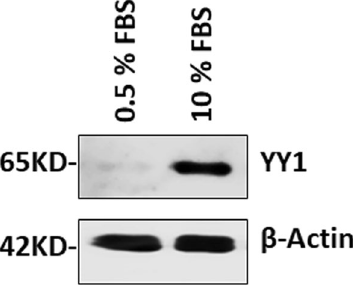
Figure 7. Serum stimulation in VSMCs induces YY1 expression and inhibits SRF binding to the SM22α gene promoter. Subconfluent PAC1 cells were cultured in 0.5% FBS for 48 h, followed by treatment with 10% FBS stimulation for 48 h. The western blot assay shows increased expression of YY1 in response to 10% FBS stimulation. β-actin is used as the loading control. The full-length original blots are presented in Supplementary Figure S5C.